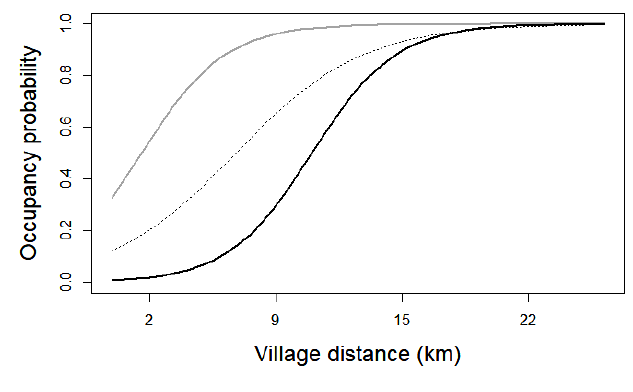
Fig. 5 . Modeled relationship between village distance and the probability of site occupancy by Bared-face Curassow. The dotted line indicates occupancy probabilities in both rivers, the black line in the Pilagá River, and the gray line in the Monte Lindo